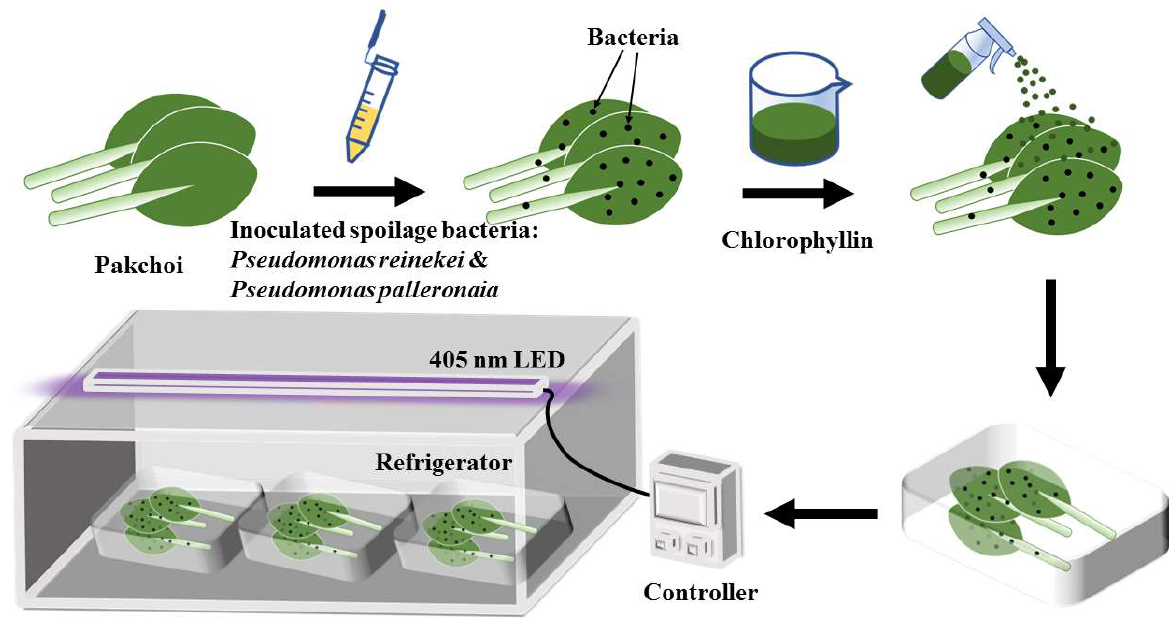
Figure 1. Schematic diagram of the Chl+light group experimental arrangement.